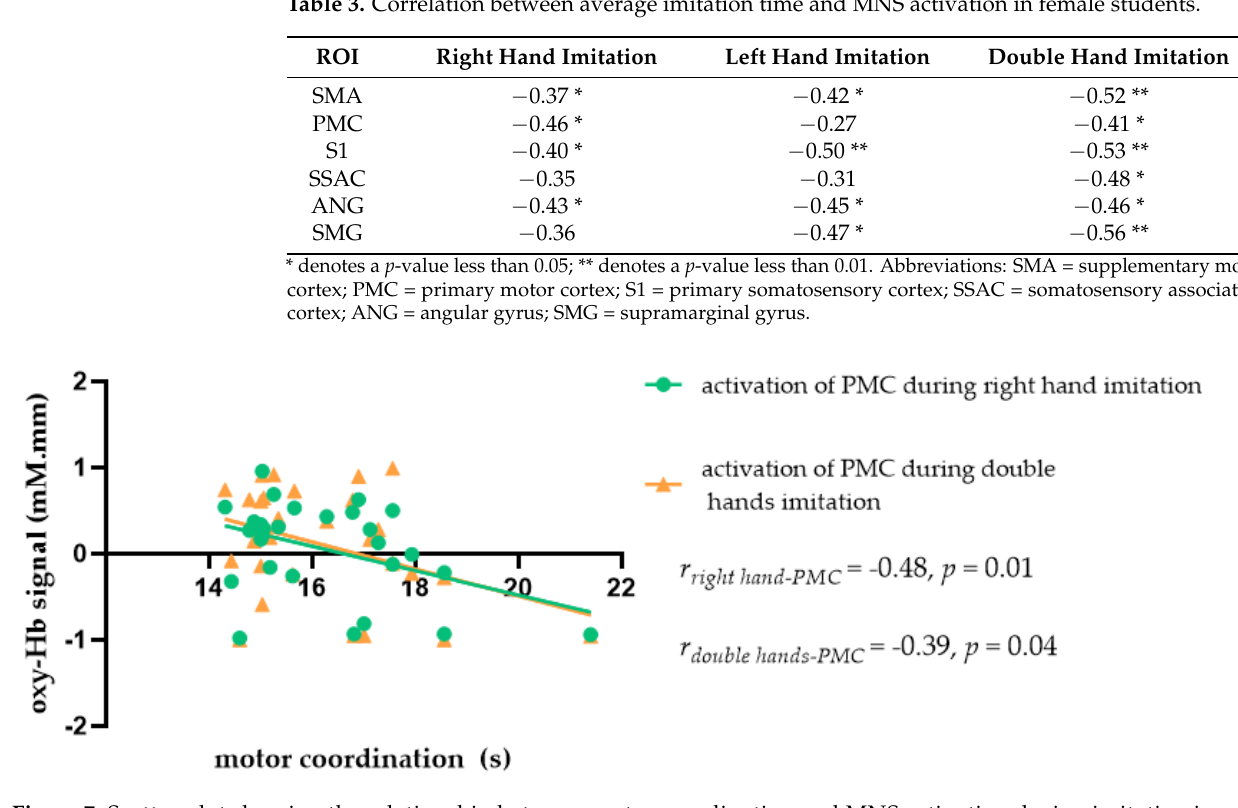
Figure 7. Scatter plot showing the relationship between motor coordination and MNS activation during imitation in female students. Table 4. Motor coordination moderates the relationship between MNS activity and imitation behavior in female students. Independent